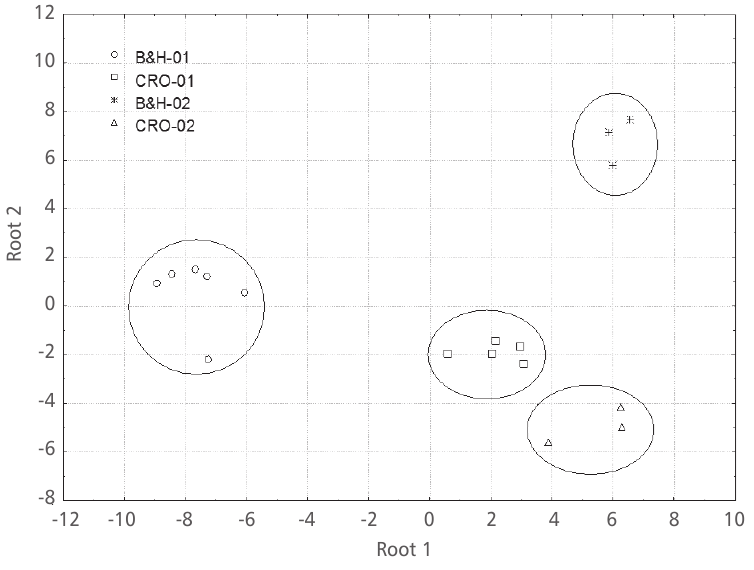
FIGure 4. Scatterplot of the canonical scores for four studied groups of Populus nigra. Particular values for the first discriminant function are on the x axis, and for the second function on the y axis